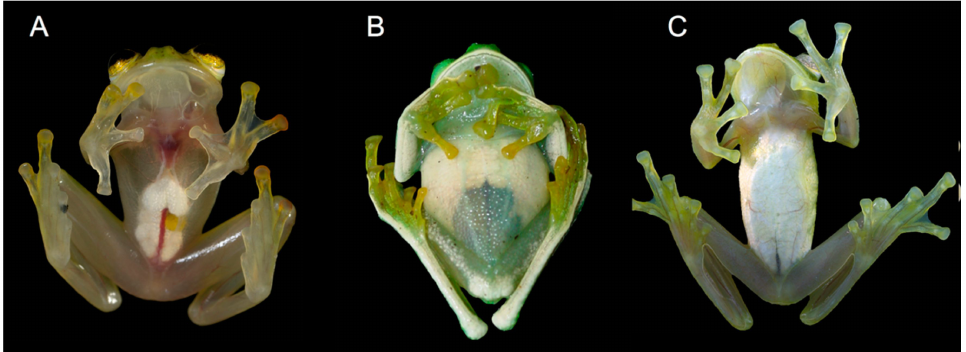
Figure 3. Ventral transparency in glassfrogs. ( A ) Complete transparency of parietal peritoneum and pericardium; H. aureoguttatum . ( B ) Partial transparency: parietal peritoneum is transparent only posteriorly; N. posadae . ( C ) Venter opaque (no ventral transparency): ventral parietal peritoneum and the urinary bladder peritoneum are opaque (white); N. gradisonae . Photos by Mart í n Bustamante.